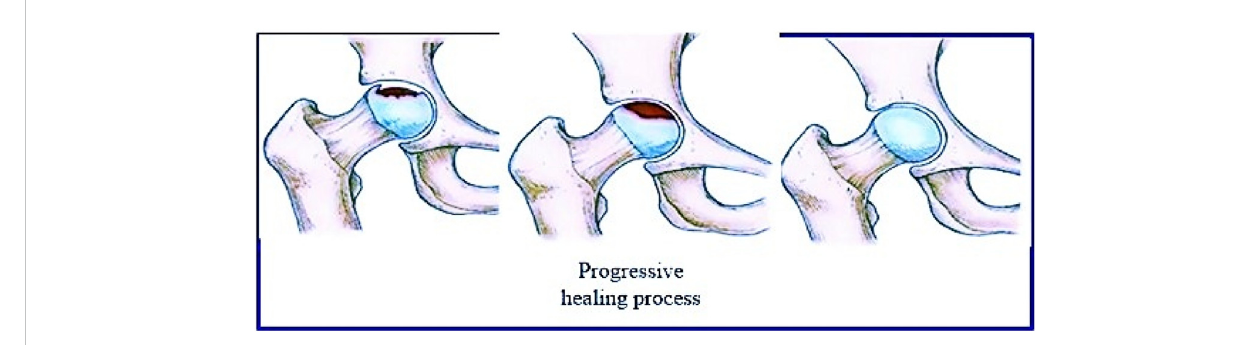
FIGURE 10 The femoral head gradually healed after necrosis (https://xn7p.cn/0f75e).